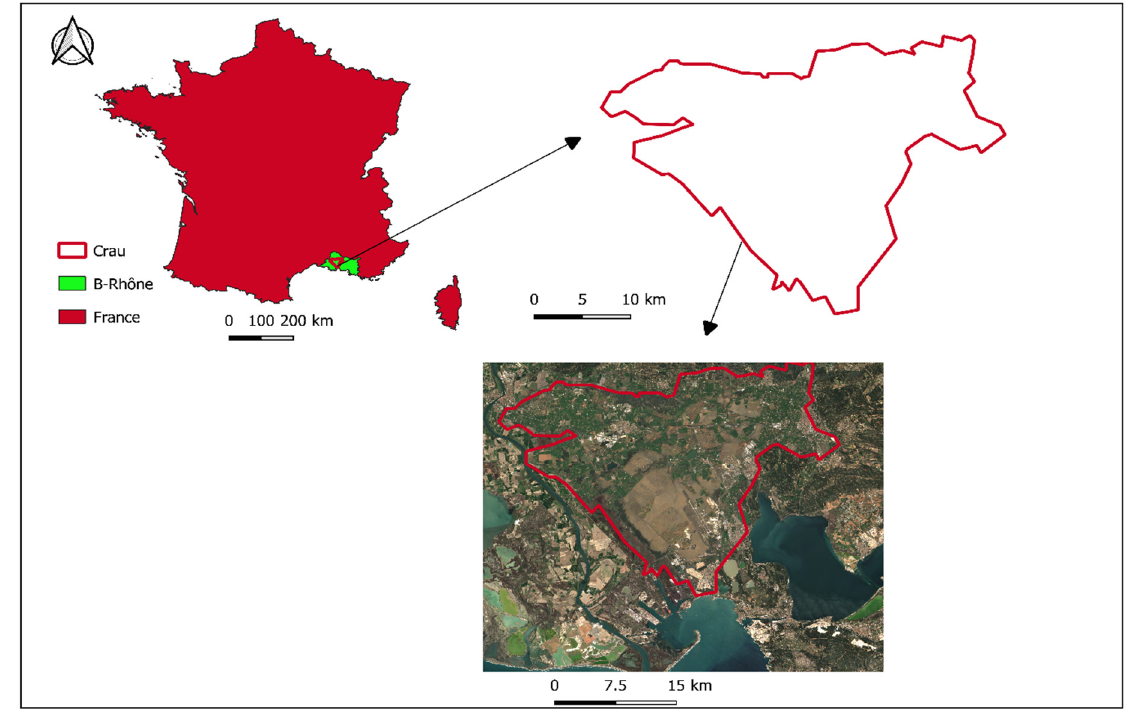
Figure 1. Study site